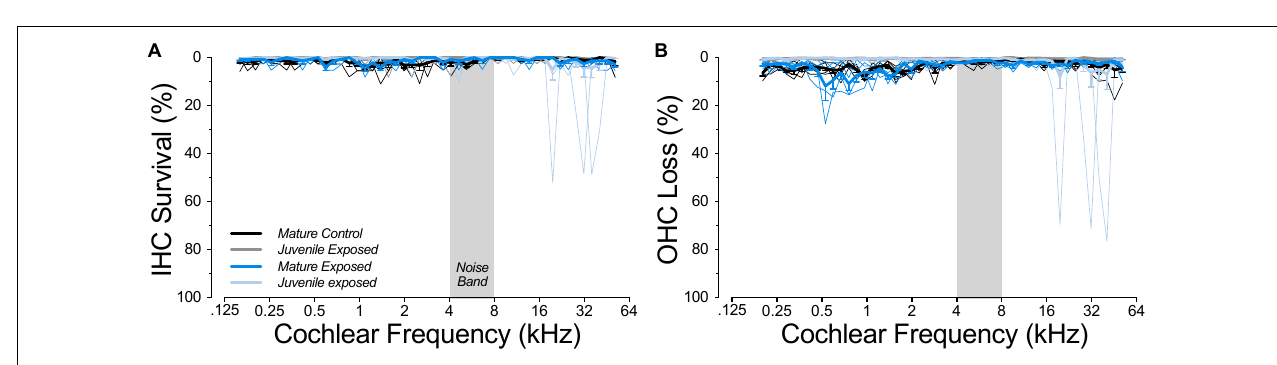
FIGURE 5 | Mature controls show more baseline OHC loss than juveniles in the apical cochlea (B) , but, in the mature ears, noise exposure did not cause any further loss of either IHCs (A) or OHCs (B) . Data are shown both as mean values ( ± SEMs; thick lines), and individual cases (thin lines): both are binned in 2% increments of cochlear location. Data from juvenile animals are from a prior study (Hickman et al., 2020). Group sizes were: mature control n = 5 ears of 4 animals, juvenile control n = 6 ears of 5 animals, mature 6 weeks n = 4 ears of 2 animals, juvenile 1 weeks n = 6 ears of 5 animals, juvenile 4 weeks n = 6 ears of 3 animals.